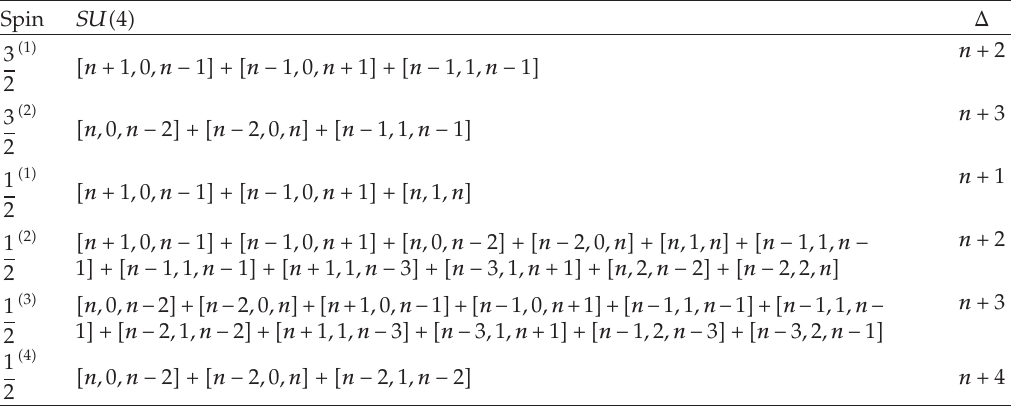
Table 4: Fermionic KK spectrum of the SW theory at level m (cid:8) 2 n (cid:12) 1, with n ≥ 1. The states with negative Dynkin labels should be excluded. In the case n (cid:8) 1 some of the fields are absent, reflecting the fact that the original S 7 multiplet is